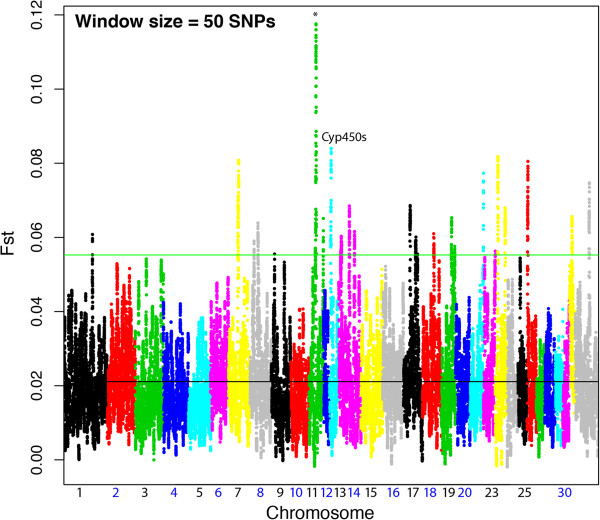
FST analysis results across the feral Andean horse genome in comparison to a mixed breed outgroupc. The top peaks are labeled with genes in the region when possible. The highest signal on Chromosome 11 contains several genes, TOM1L1, COX11, STXBP4, HLF, MMD, TMEM100, and PCTP. The Fst data was corroborated by a highly significant association found between COX11/STXBP4, which is perhaps the most biologically interesting.